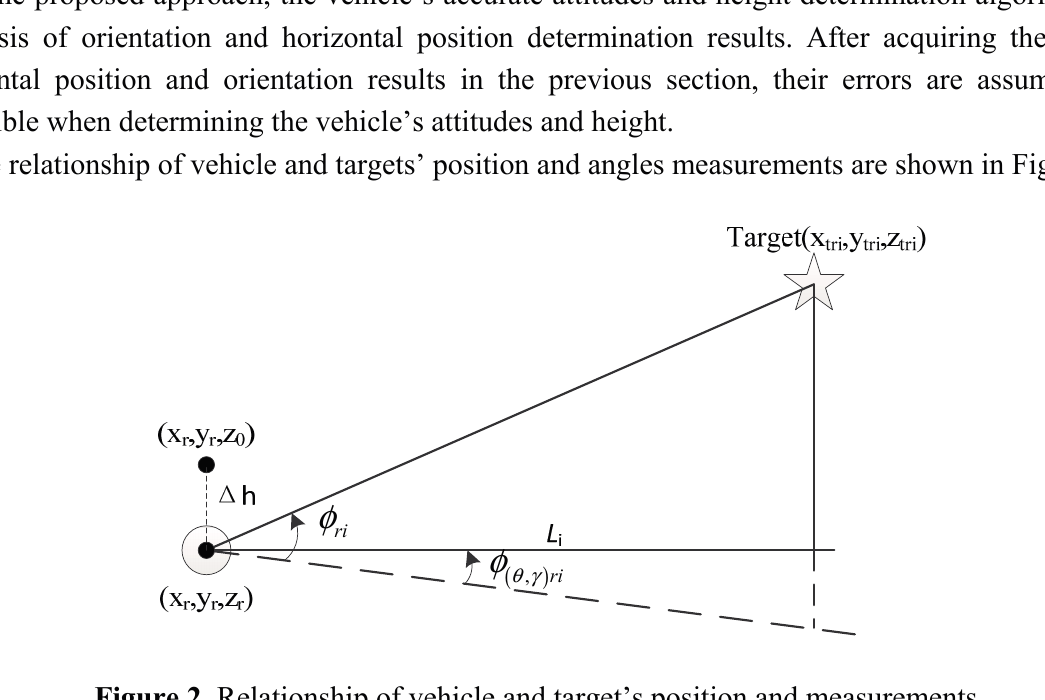
Figure 2. Relationship of vehicle and target’s position and